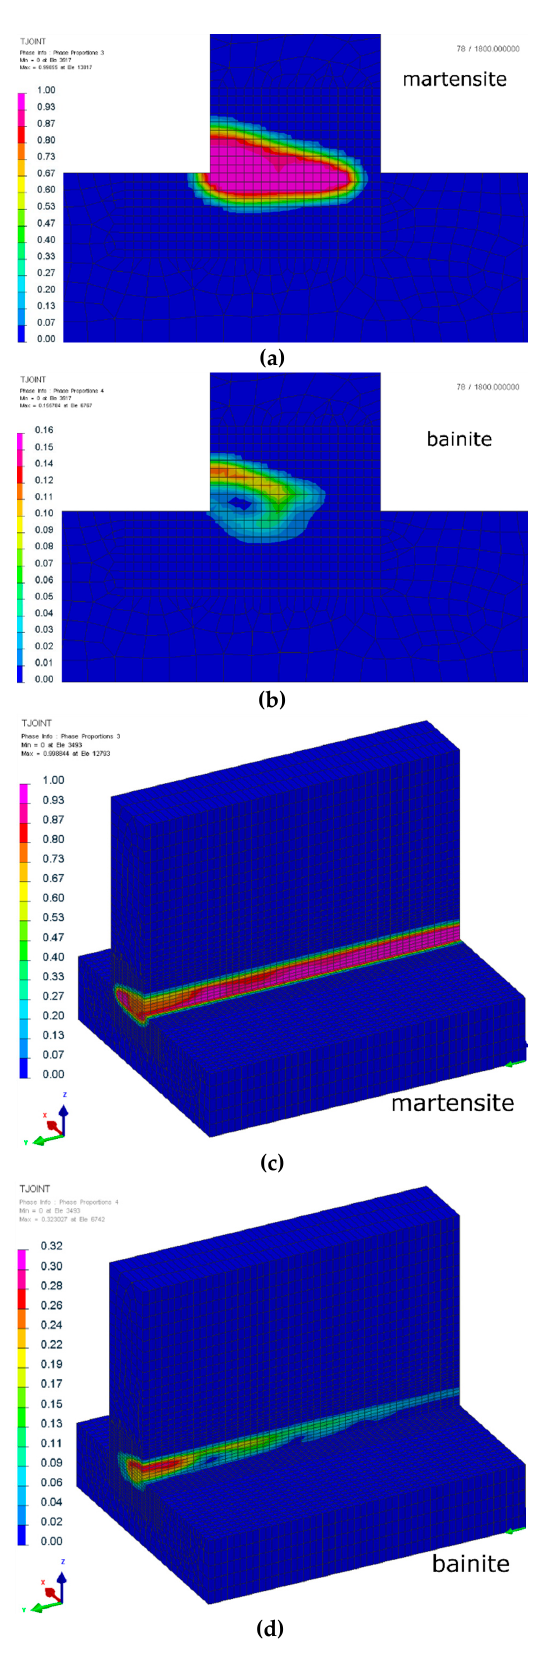
Figure 6. Distribution of ( a , c ) martensite and ( b , d ) bainite phases after laser welding of S700MC steel T-joints with a thickness of 10 mm (cross-sections were made in the half-length of the joint). In the case of hybrid welding, the cooling rates were lower due to the presence of additional heat from the MAG heat source. This additional portion of heat coming from the MAG electric arc resulted in a significant decrease in cooling speed, and it is clearly visible in the thermal cycle graph, in addition to the distribution of bainite and martensite at the distribution of metallurgical phases. Of course, the maximal amount of the bainite was about 97% in the area only heated with the laser. However, in the most areas of the weld (remelted or heat affected by MAG arc), the maximum amount of martensite did not exceed 20–30%. The distribution of bainite also corresponded to the decrease in cooling rates mentioned above. In the area of the MAG heat source, the maximum range of bainite was about 97% (Figure 7).